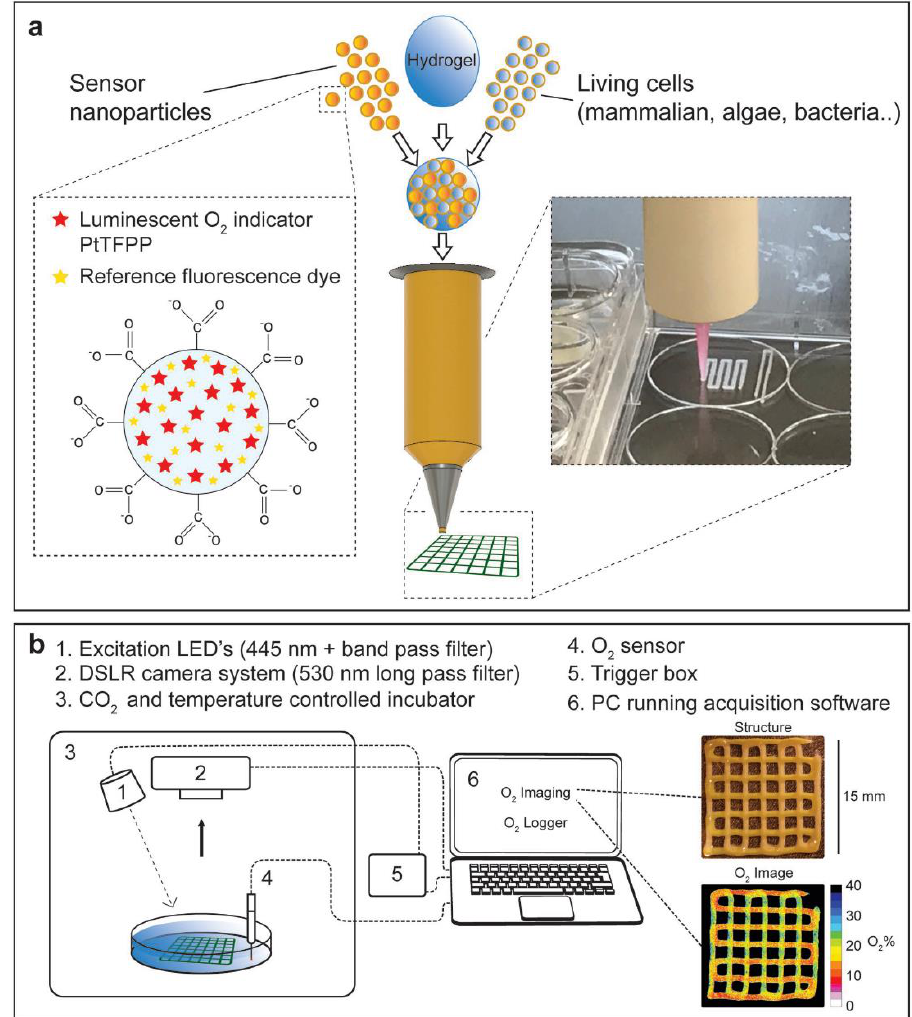
Figure 8. A novel 3D bioprinting approach with hydrogel bioinks functionalized with luminescent nanoparticles. ( a ) Cells and/or nanoparticles, containing the O 2 -sensitive luminescent indicator PtTFPP compound and an inert fluorescent coumarin dye, were incorporated into an alginate-based bioink for bioprinting. ( b ) Experimental setup used to image O 2 distribution in bioprinted hydrogel constructs.